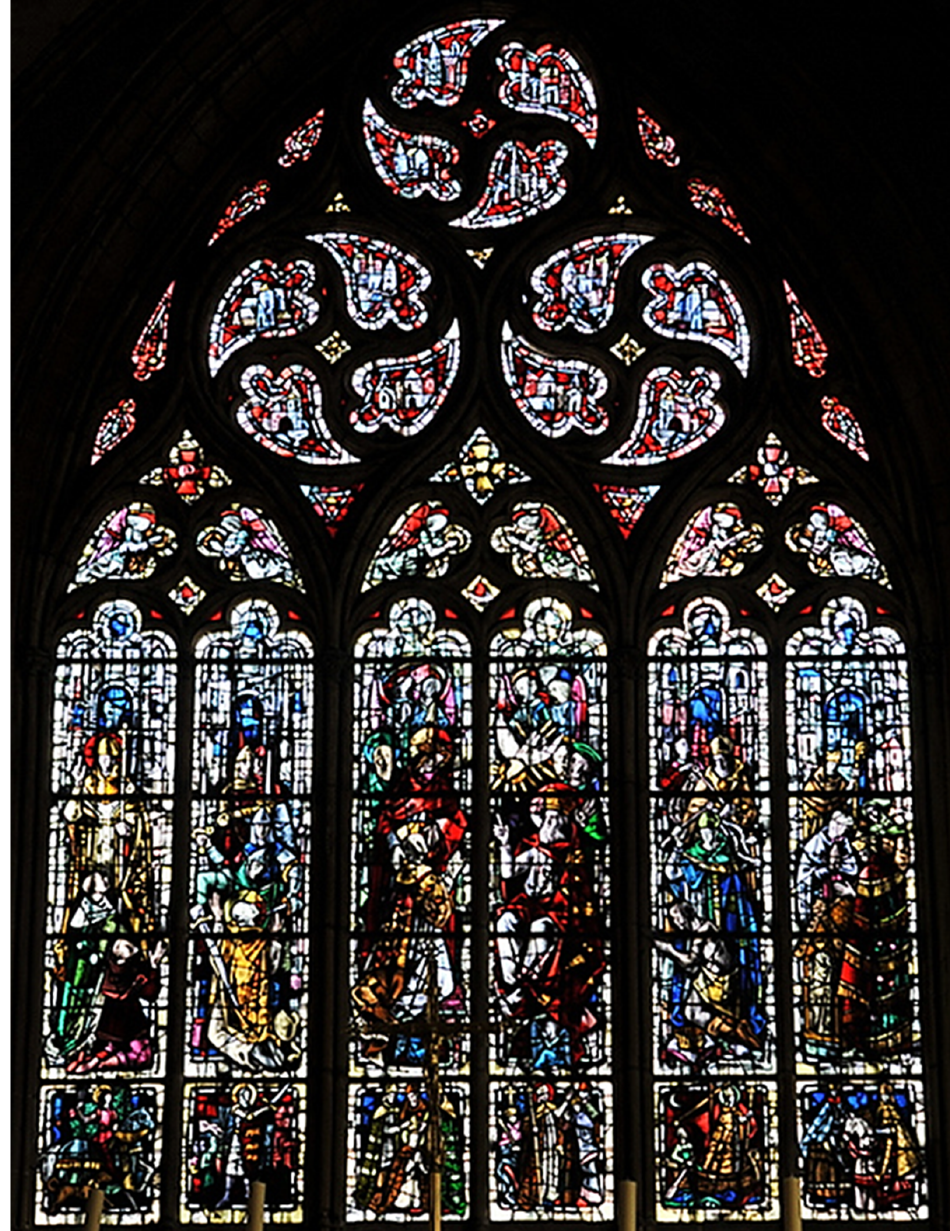
Figure 10. Saint-Lô, Church of Notre-Dame, Saint-Thomas chapel, Life of Saint Thomas window, 1968, Max Ingrand, glazier. © author. 1968, Max Ingrand, glazier. ©